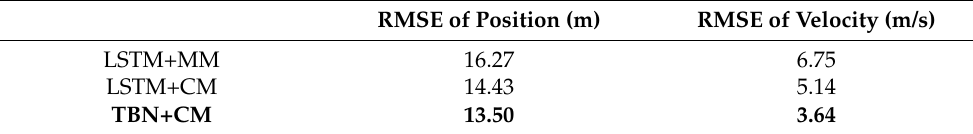
Table 2. Numerical results of several methods for tracking segmented trajectories.